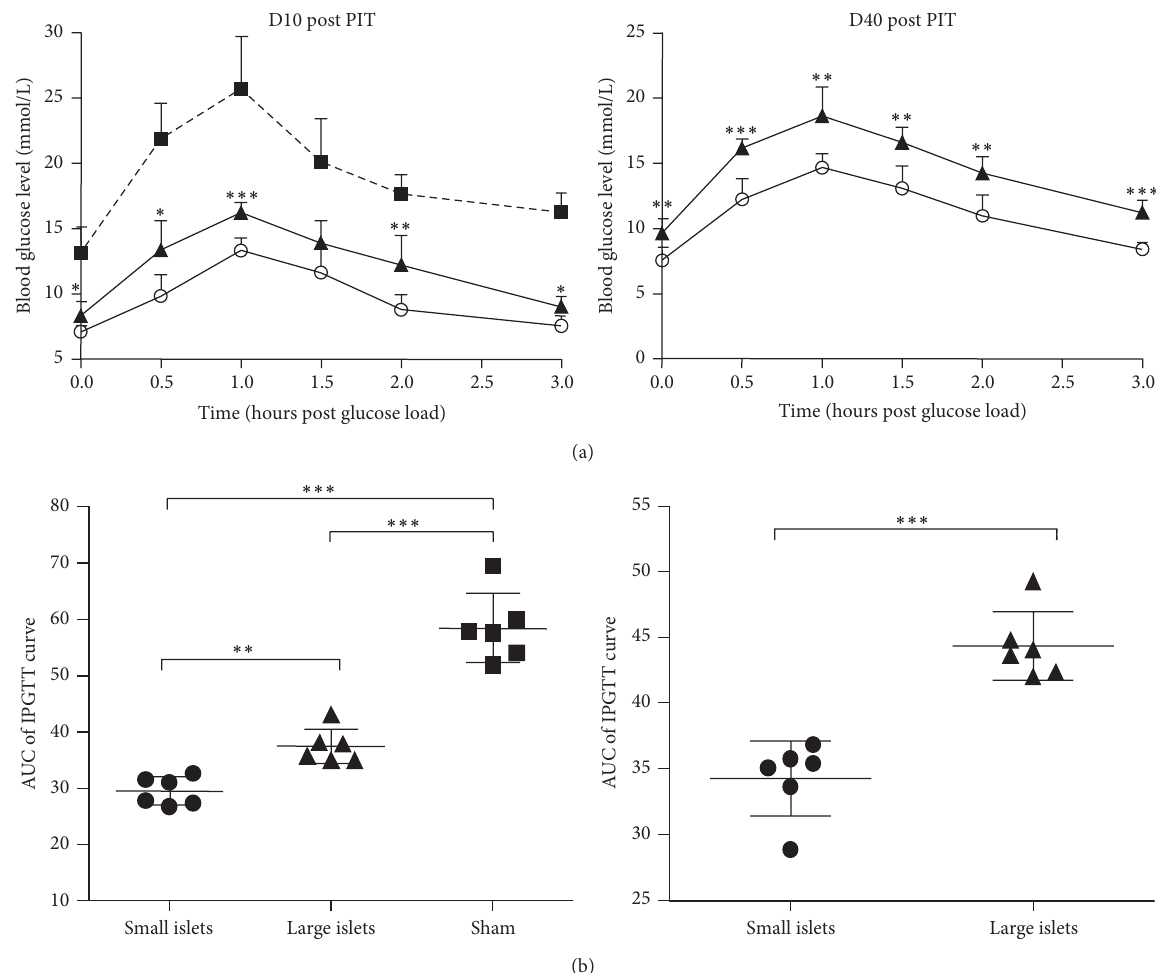
Figure 4: IPGTT of rat recipients after PIT at indicated time points. (a) IPGTT of rat recipients after PIT at d10 and d40, respectively. At the 10th day after PIT, the glucose levels of indicated time after intraperitoneal glucose challenge were significantly higher in large islets PIT group than in small islets PIT group ( 𝑃 = 0.0335 , 0.0106, 0.0002, 0.0507, 0.0078, and 0.0103 for 0 h, 0.5 h, 1h, 1.5h, 2 h, and 3 h, resp.). At the 40th day, the small islets recipient group demonstrated a better glucose tolerance ( 𝑃 = 0.0074 , 0.0002, 0.0028, 0.002, and 0.0026 and 𝑃 < 0.0001 at 0 h, 0.5 h, 1h, 1.5h, 2 h, and 3h, resp., during IPGTT). (b) Comparison of AUCs calculated from IPGTT curves above also indicated both better short-term effectivity and longevity of small islets transplantation (for both 𝑃 < 0.0001